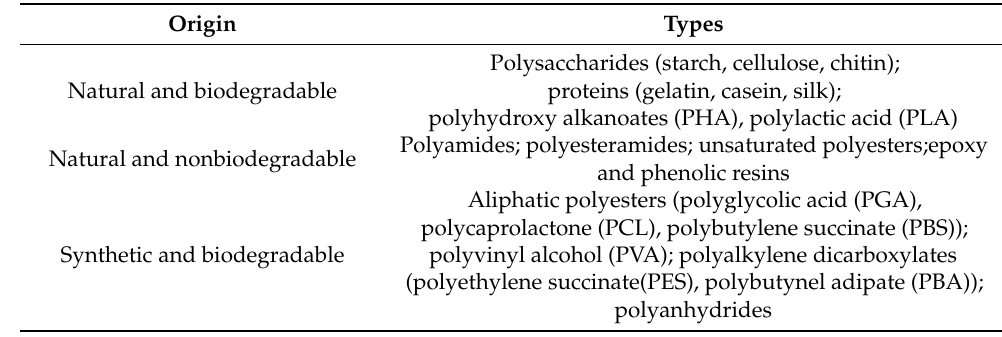
Table 2. Polymers used in food packaging applications.